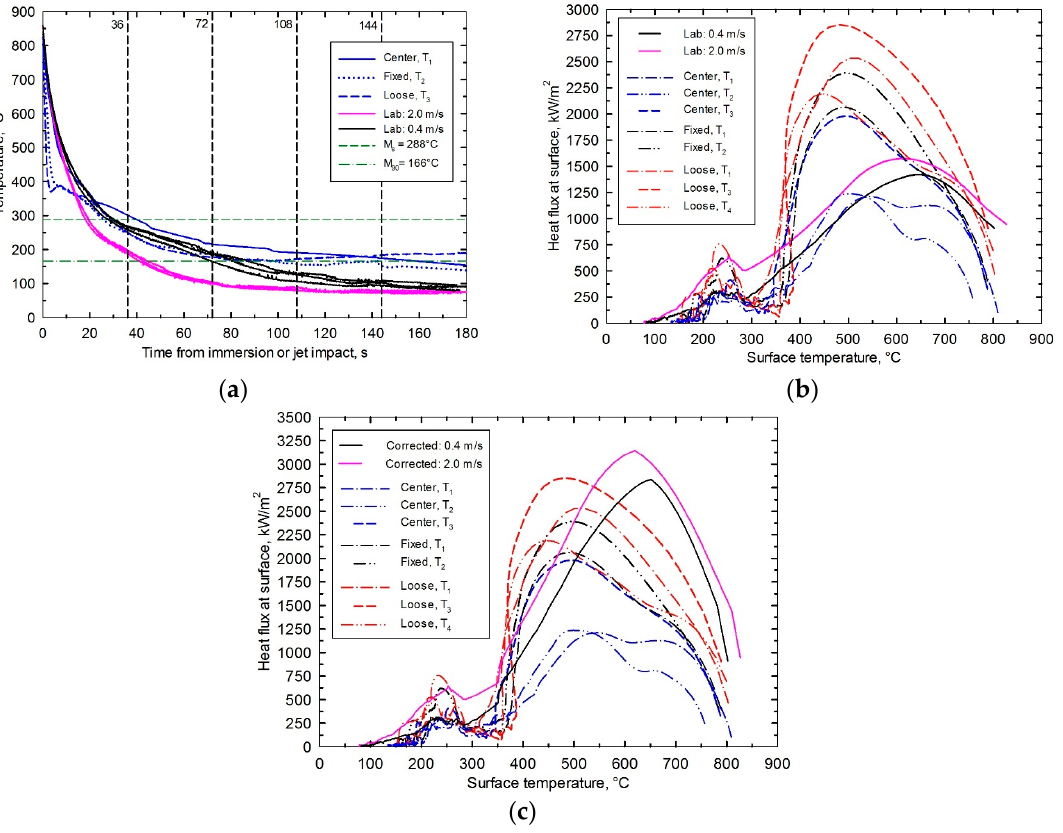
Figure 9. Comparison of plant and laboratory results: ( a ) measured temperature evolution, ( b ) boiling curves and ( c ) boiling curves with Taylor wavelength correction.